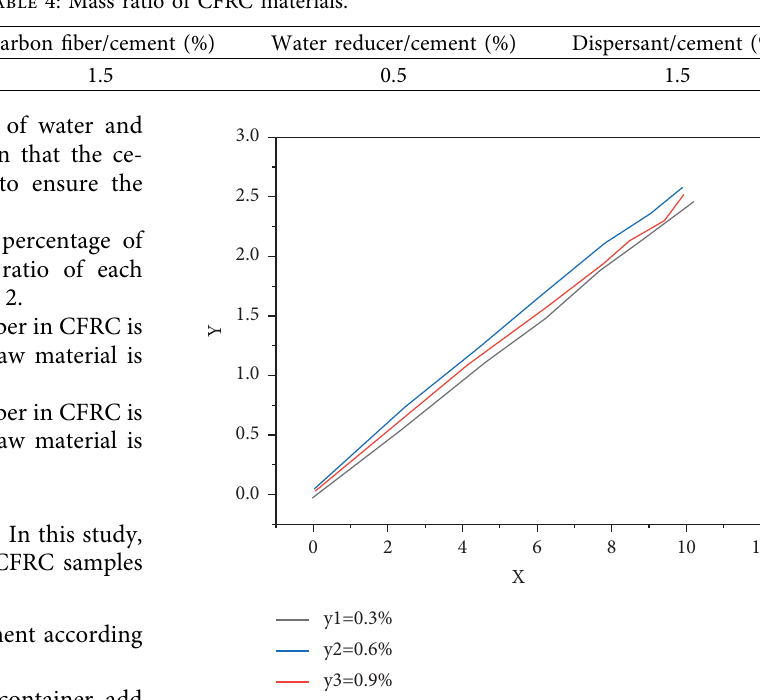
Figure 2: Stress-strain diagram of CFRC